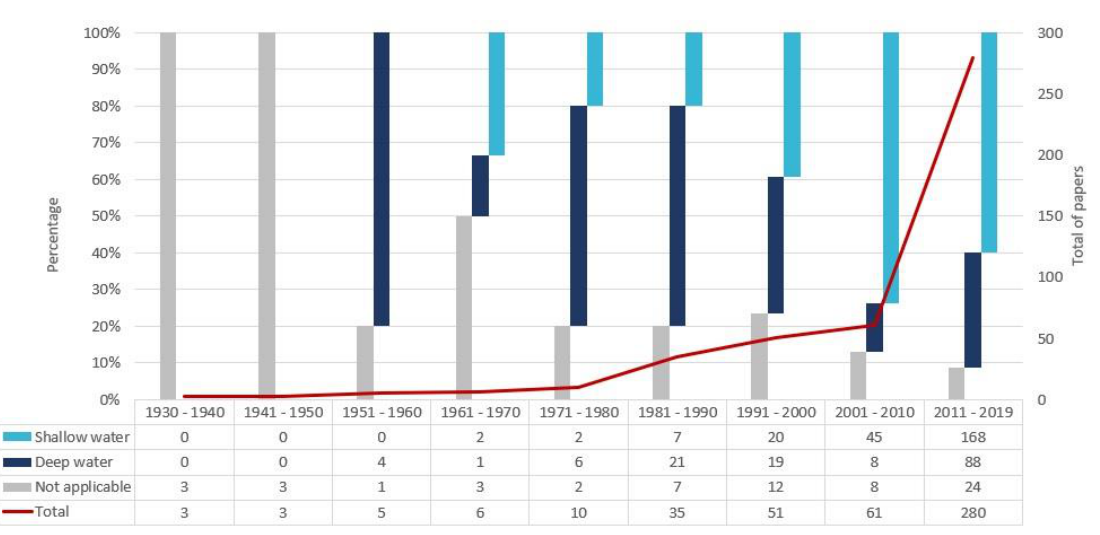
Figure 2. Deep/shallow water context in the manuscripts with the keyword “seabed mapping” by Figure 2. Deep / shallow water context in the manuscripts with the keyword “seabed mapping” decade. by